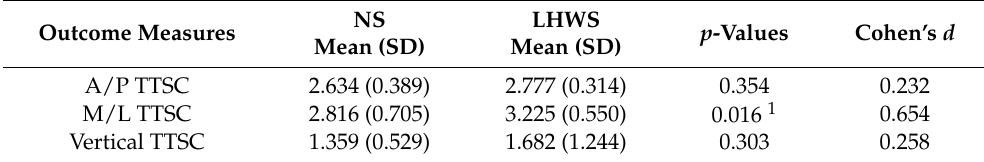
Table 3. Time to stabilization for the center of mass